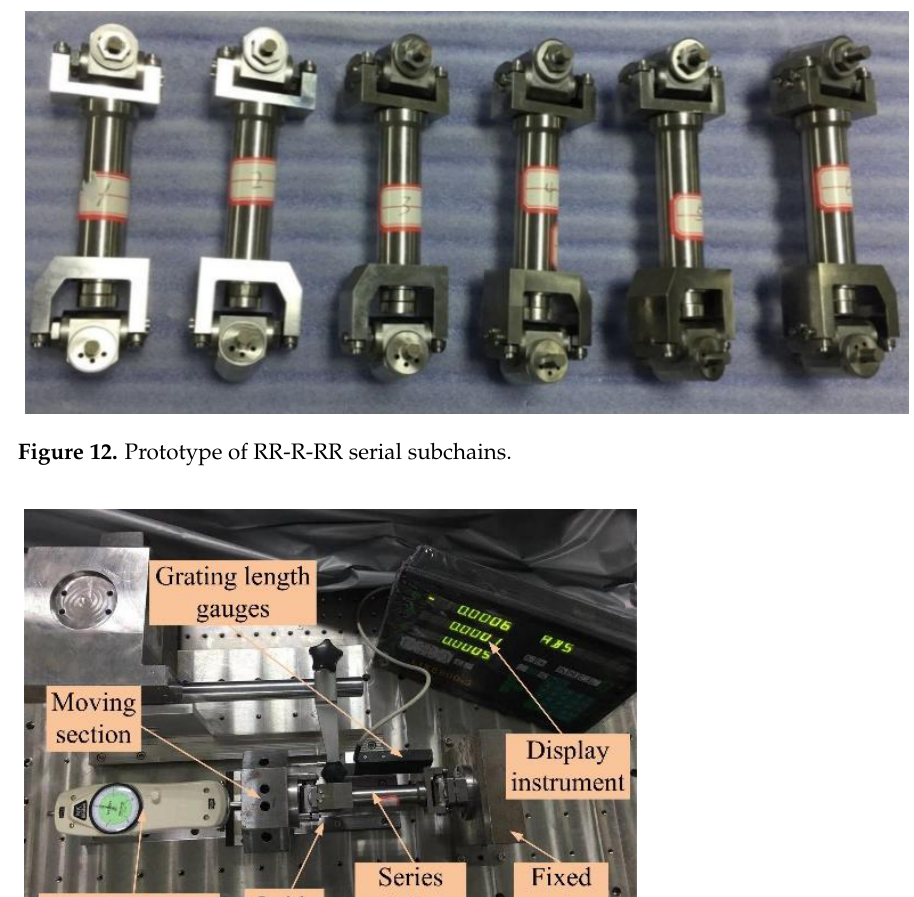
( b ) Figure 11. Path tracking errors: ( a ) Position error; ( b ) Directional attitude angle error. 4. Research on Platform Performance Testing 4.1. Static Stiffness Testing 4.1.1. Stiffness Testing of the Subchain The actual RR-R-RR subchain is pictured in Figure 12. The stiffness of the series